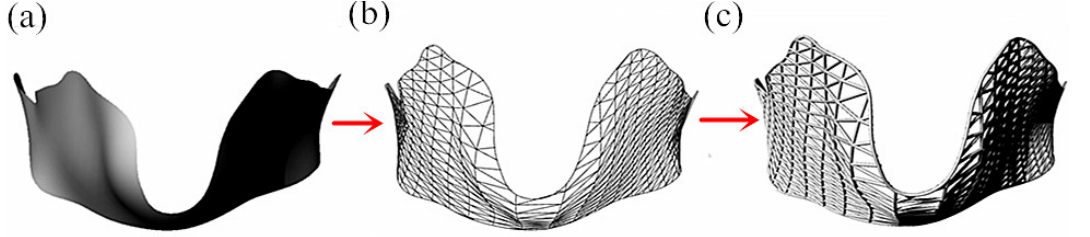
Figure 4. Design process of single-layer grid structure for thyroid cartilage prosthesis after total resection: ( a ) surface model; ( b ) line model; ( c ) volume model.